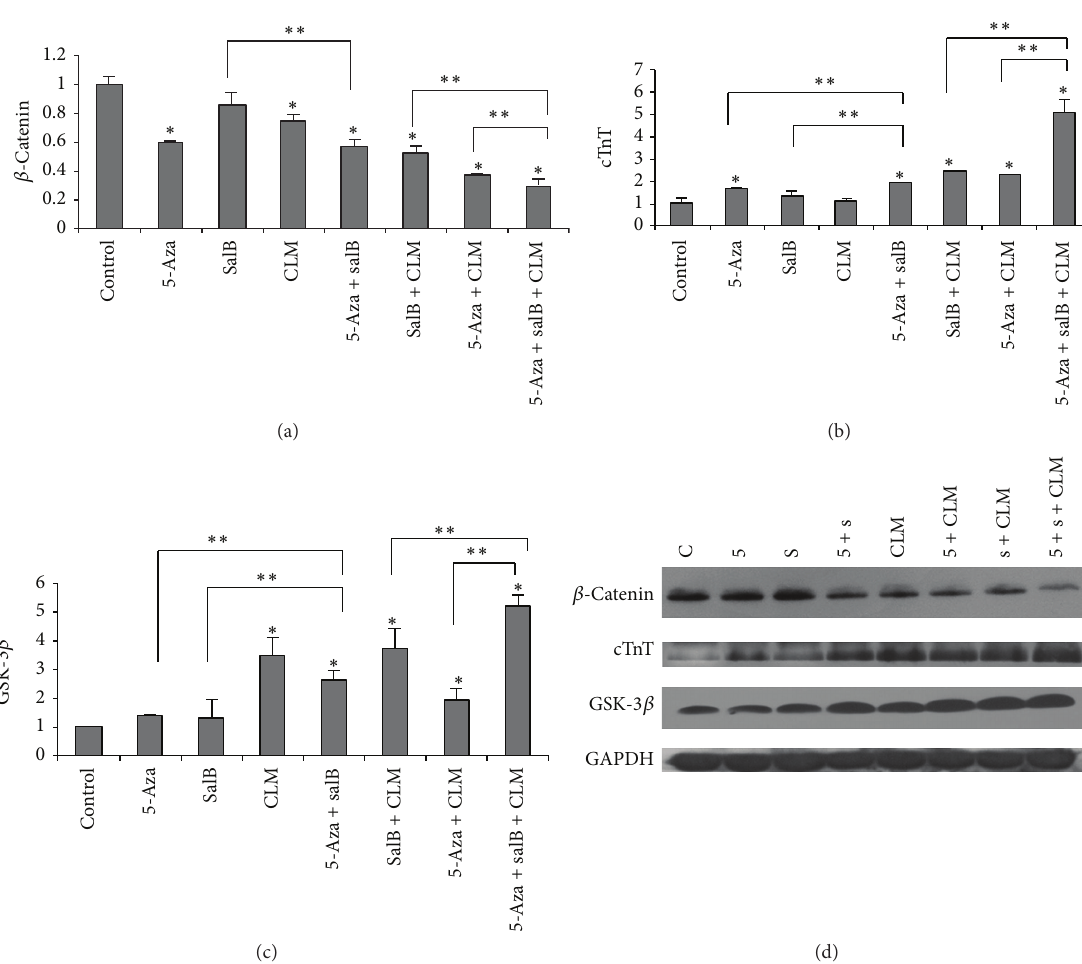
Figure 4: mRNA and protein expressions of beta-catenin, cTnT, and GSK-3beta detected by qPCR and Western blotting in MSCs. (a) Beta- catenin mRNA expression; (b) cTnT mRNA expression; (c) GSK-3beta mRNA expression; (d) protein expression of beta-catenin, cTnT, and GSK-3beta was detected by Western blotting. The group sequence from left to right is control group, 5-aza, SalB, 5-aza+SalB, CLM, 5- aza+CLM, SalB+CLM, and 5-aza+SalB+CLM. Results are shown as the mean ± SD values. Experiments were repeated three times. ∗ 𝑃 < 0.05 compared to the control group. ∗∗ 𝑃 < 0.05 compared between the two groups as shown in the